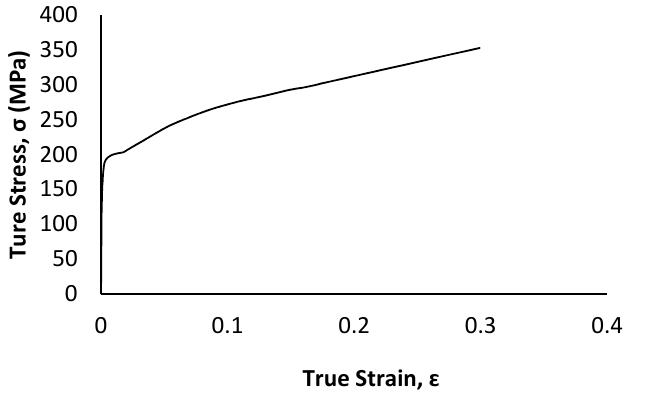
Figure 19. The true stress-true strain curves of an AISI 1008 steel (Data obtained with permission from [26], 2014, Elsevier).